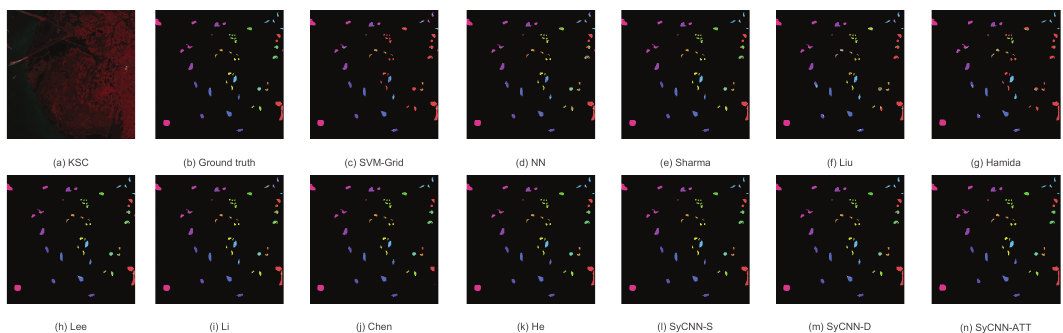
Figure 10. Visualization of the experimental results based on KSC: ( a ) Indian Pines, ( b ) Ground truth, ( c ) SVM-Grid, ( d ) NN, ( e ) Sharma, ( f ) Liu, ( g ) Hamida, ( h ) Lee, ( i ) Li, ( j ) Chen, ( k ) He, ( l ) SyCNN-S, ( m ) SyCNN-D, ( n ) SyCNN-ATT. It is observed that the outputs produced by our proposed models are quite close to the Ground truth.